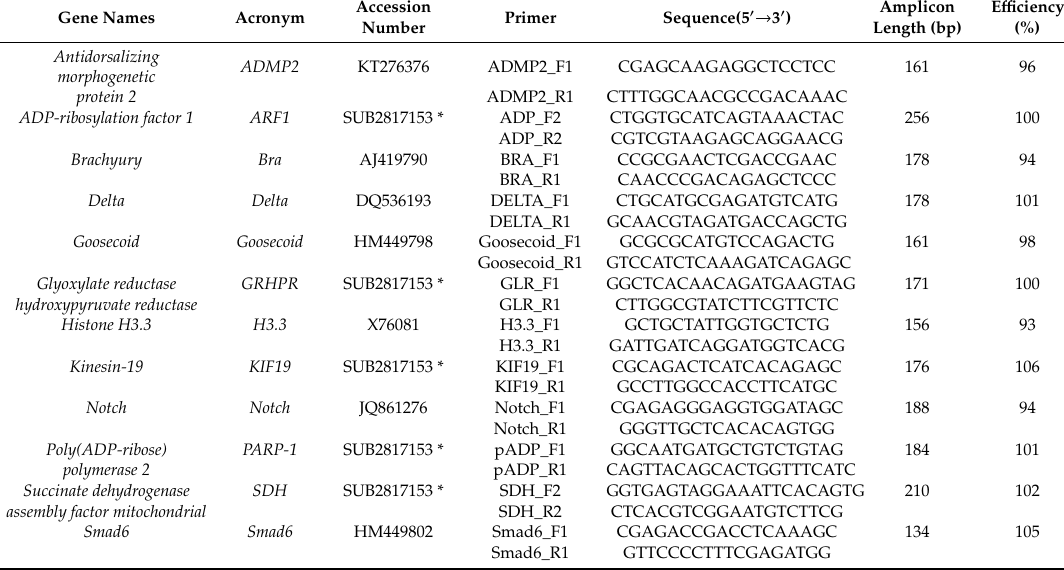
Table 2. Gene name, acronym, accession numbers, primer names, primer sequences, primer e ffi ciency, and amplicon lengths of PCR fragments. Accession number indicated with * derived from